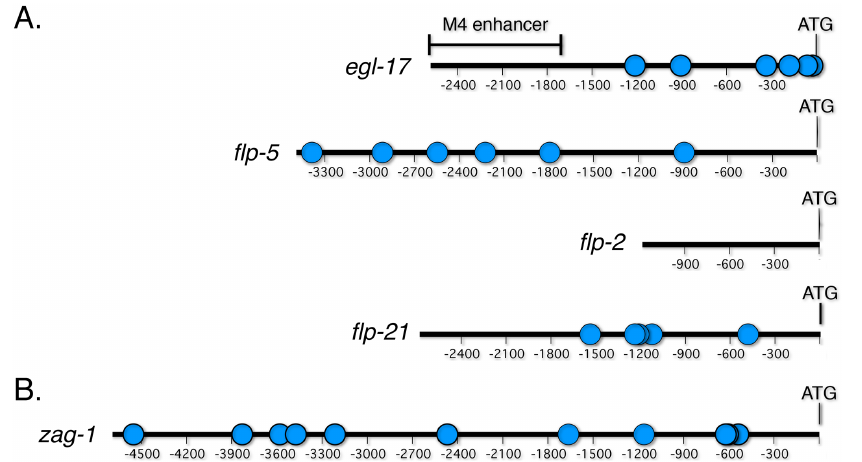
Figure 1. Promoters of potential CEH-28 target genes. Schematic diagrams of promoter fragments in gfp fusions used in this study with potential CEH-28 binding sites indicated (blue dots). The translational start site (ATG) is numbered as bp 1. (A) egl-17 contains an M4 specific enhancer (bar). Potential CEH-28 binding sites are located in egl-17 at 2 1212, 2 906, 2 334, 2 179, 2 59, and 2 24; in flp-5 at 2 3387, 2 2914, 2 2546, 2 2225, 2 1793, and 2 892; in flp-21 at 2 1536, 2 1238, 2 1212, 2 1123, and 2 480. (B) Schematic diagram of the zag-1 promoter sufficient for zag-1 expression in M4 and other neurons [15]. Our studies used fosmid WRM063aA08 containing a gfp translational fusion [45], which is expressed in similar pattern. zag-1 contains potential CEH-28 binding sites at 2 4552, 2 3830, 2 3581, 2 3474, 2 3214, 2 2468, 2 1664, 2 1162, 2 619, 2 604, and 2